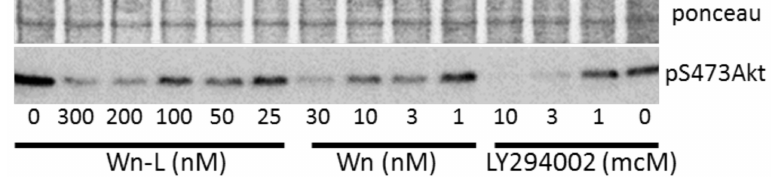
Figure 1. S473AKT phosphorylation in C4-2 prostate cancer cells. C4-2 cells were treated with Wn-L ( 10 ) (300, 200, 100, 50, 25nM), Wn ( 1 ) (30, 10, 3, 1 nM) or LY294002 (10, 3, 1, 0 µ M) as indicated for 1 h, and analyzed for S473AKT phosphorylation. Region of the membrane corresponding to 60–70 kDa stained with Ponceau S is shown as control of equal